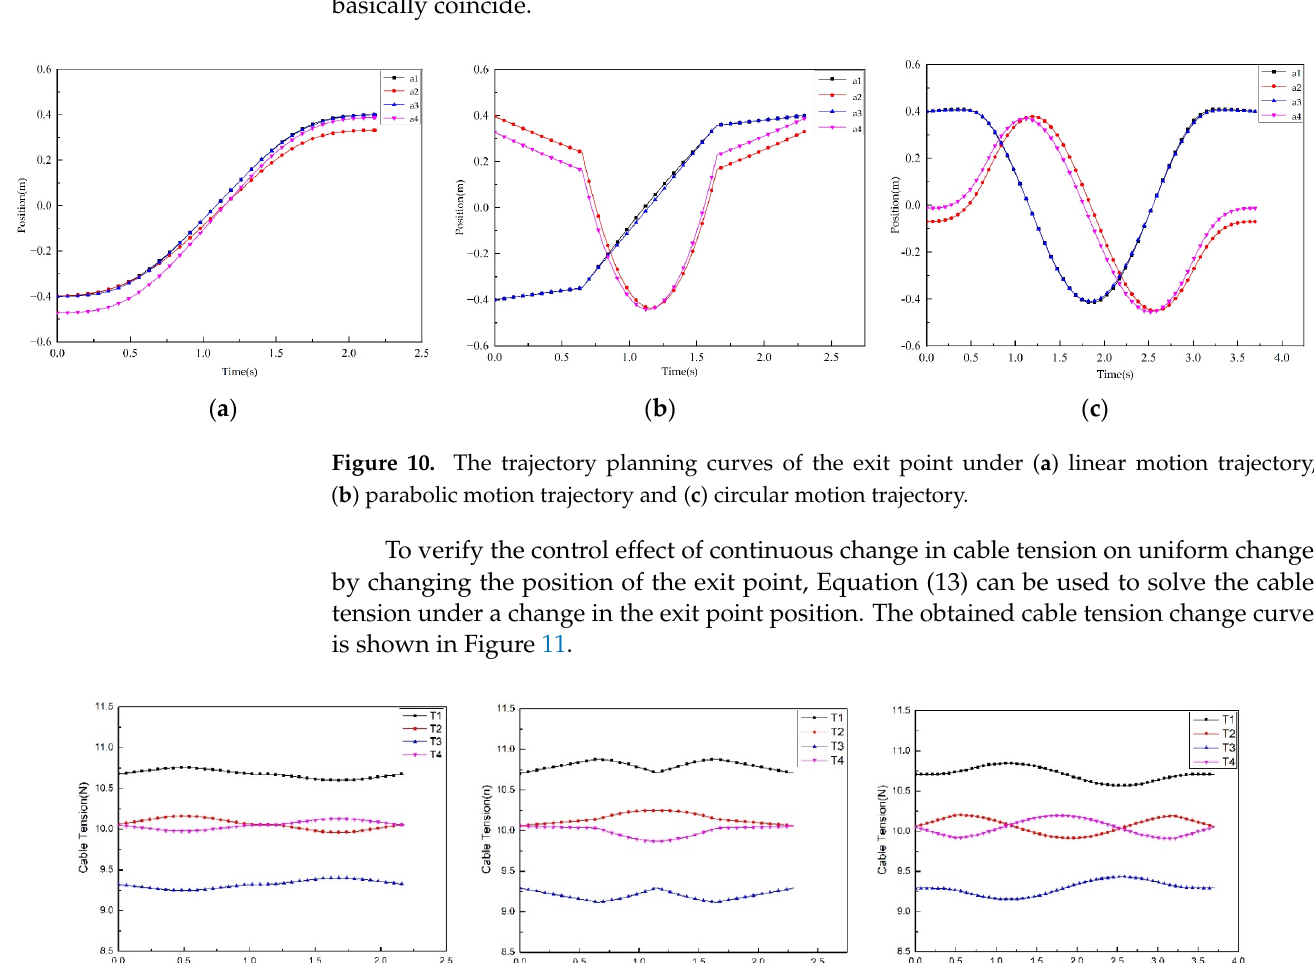
( c ) Figure 9. Cable tension–time curve of ( a ) linear motion trajectory, ( b ) parabolic motion trajectory, and ( c ) circular motion trajectory. According to the calculation results of cable tension in the fixed configuration, the change degree of cable tension is expressed by the standard deviation. The maximum standard deviation of cable tension in the four cables in the straight track is 3.0063 N, that in the parabolic track is 3.0446 N, and that in the circular track is 2.8665 N. According to the analysis of the cable tension curve in Figure 9, the cable tension of the cable-driven